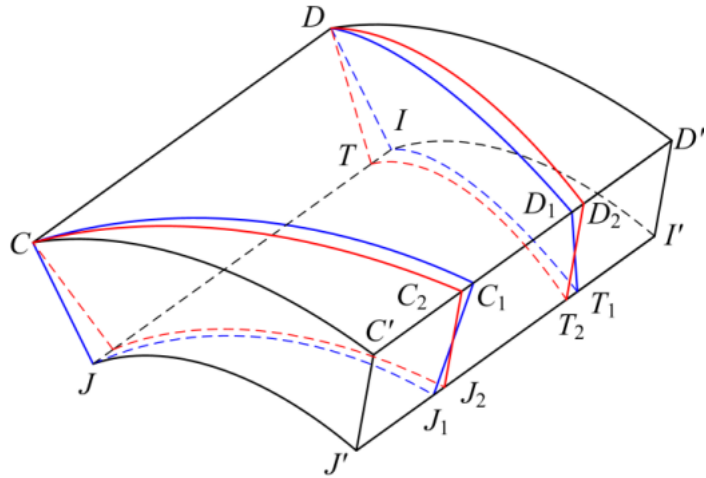
Figure 10. Section design of the throwing arc segment outlet.